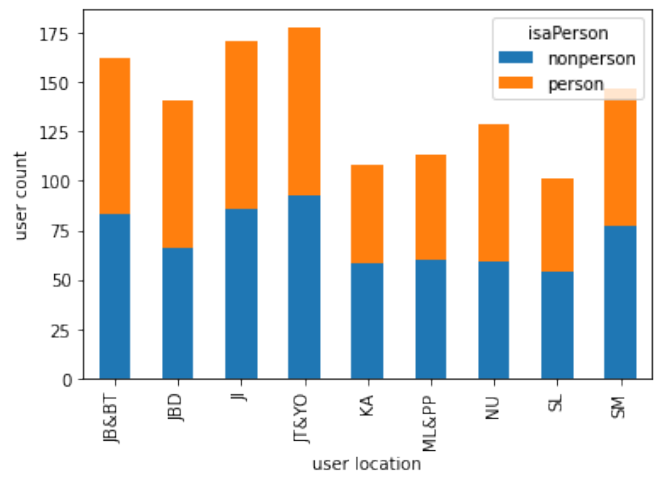
Figure 4. Users’ location distribution.